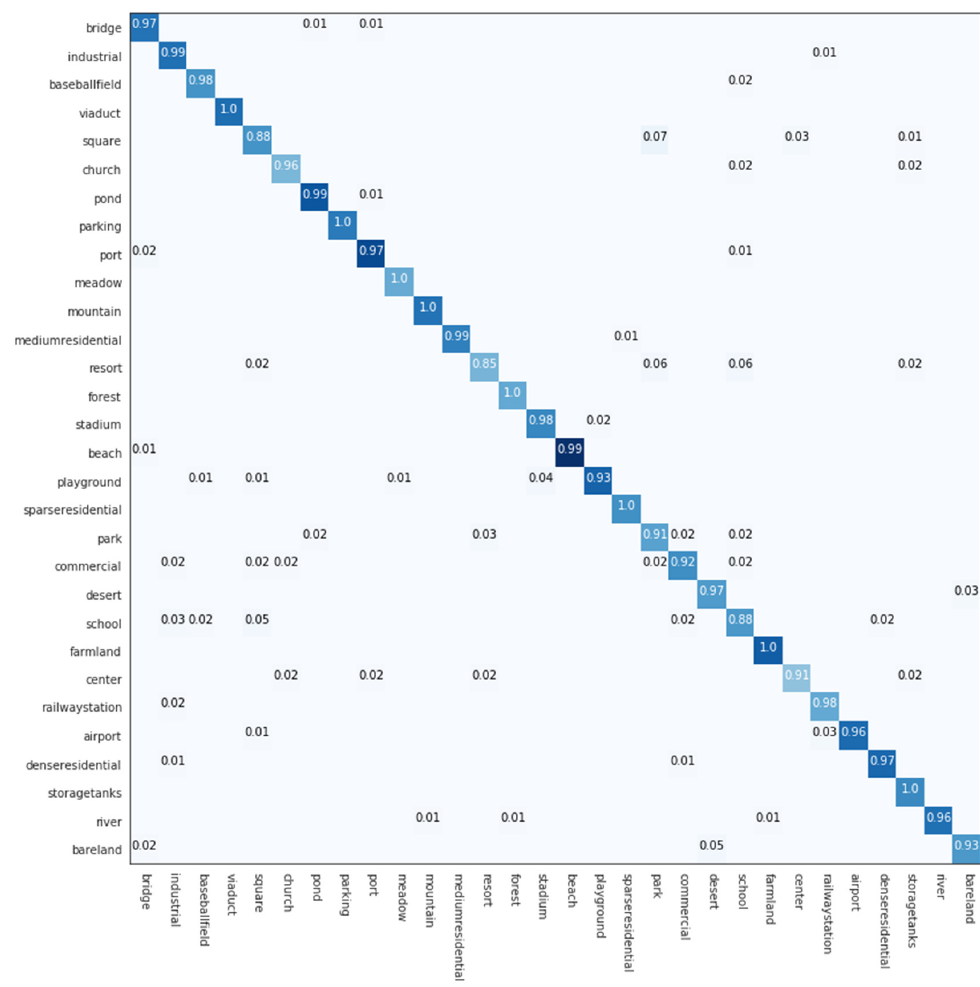
Figure 8. Confusion matrices of the DDRL-AM framework with 80% training data of AID. The results in Figure 8 correspond to results shown in Table 4.